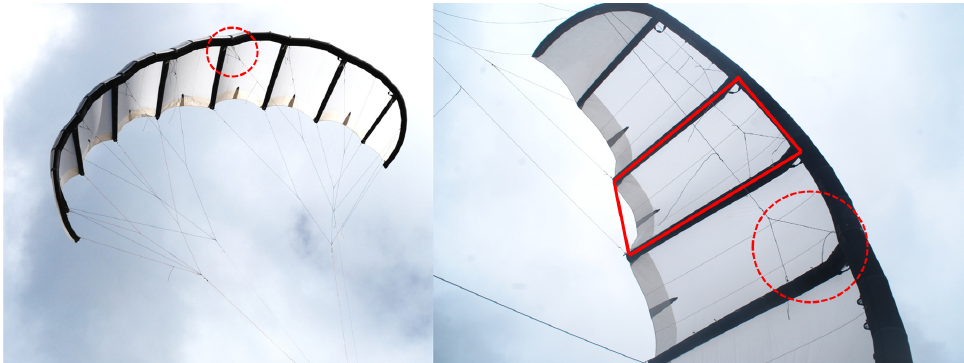
Figure 2. Two photos of the LEI V3 kite in flight: the red quadrilateral indicates the structural model of one of the wing segments, and the red circles indicate Y-splits of the bridle close to the tubes to distribute the transmitted load